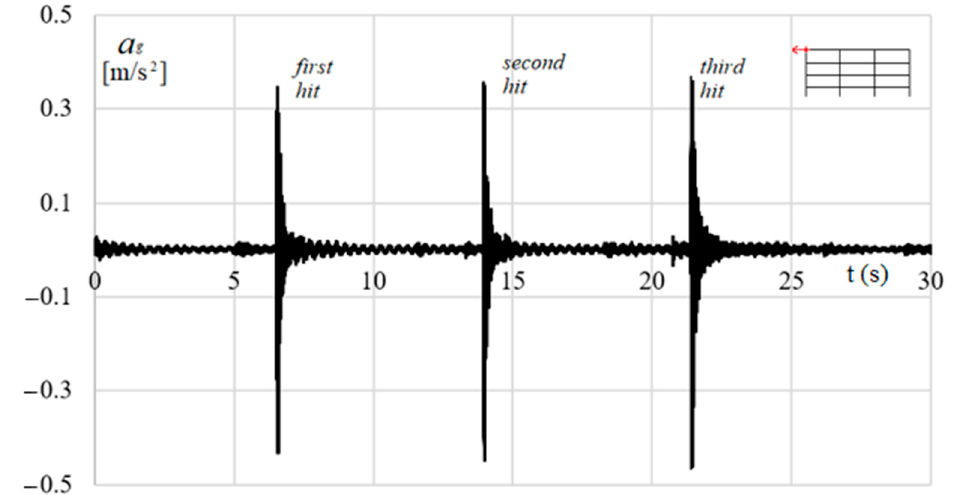
Figure 8. Example of an output obtained from the tests in longitudinal direction.